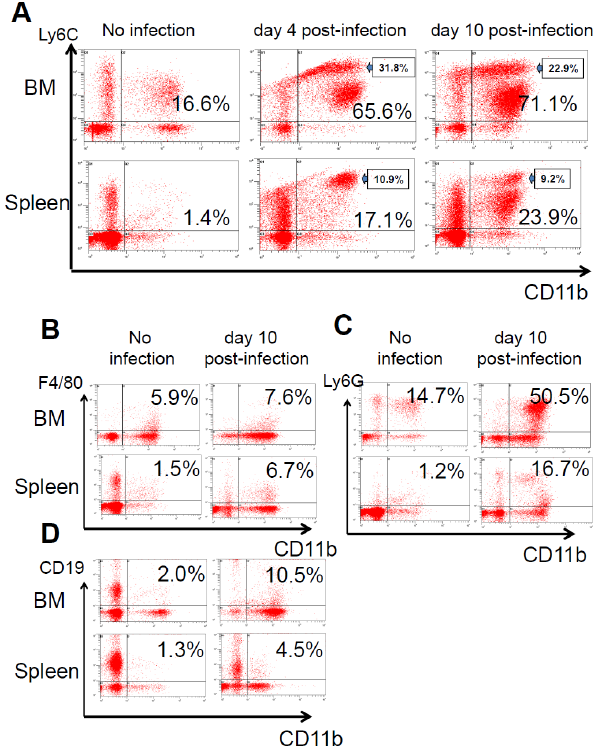
Figure 4. Changes in the CD11b + population during infection. Mice were infected with B. pseudomallei -GFP. At the indicated times, the cellular populations were analyzed after double staining for monocytes (A, CD11b + Ly6C + ), macrophages (B, CD11b + F4/80 + ), neutrophils (C, CD11b + Ly6G + ) and CD11b + CD19 + B cells (D).